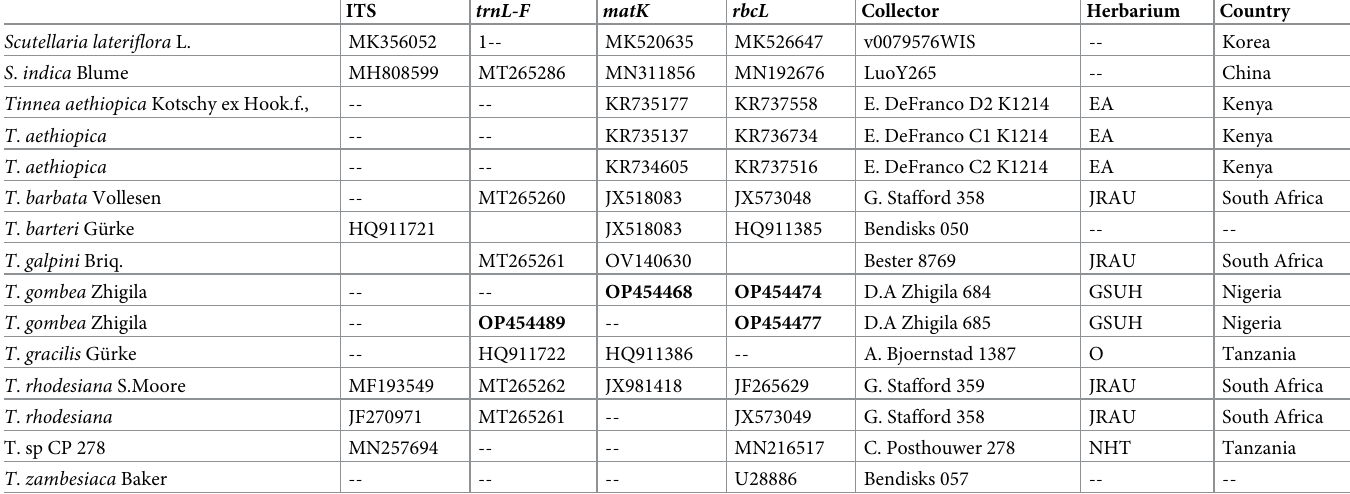
Table 1. Information on the accessions used in this study. GenBank numbers for new species are in bold. matK , rbcL OP454474 and OP454477, trnL-F : OP454489, the nuclear ITS. ITS trnL-F matK rbcL Collector Scutellaria lateriflora